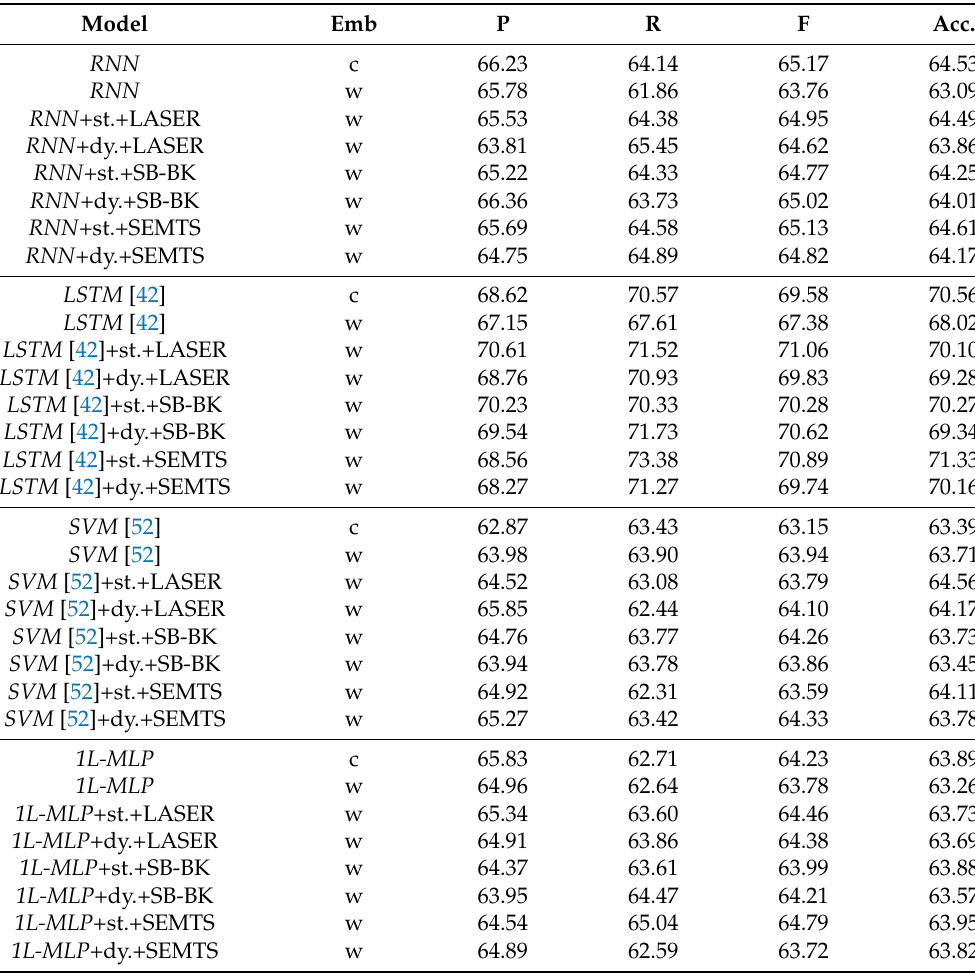
Table A1. The evaluation results of other methods on BQ. 1L-MLP stands for a one-layer MLP, LR stands for logistic regression [51], and DCNN stands for a dynamic convolutional neural network with k-max pooling [47]. When SVM, MLP, and LR are used for evaluation, the sentence representation is obtained by implementing average pooling transformation on the variable-length word (character) embedding